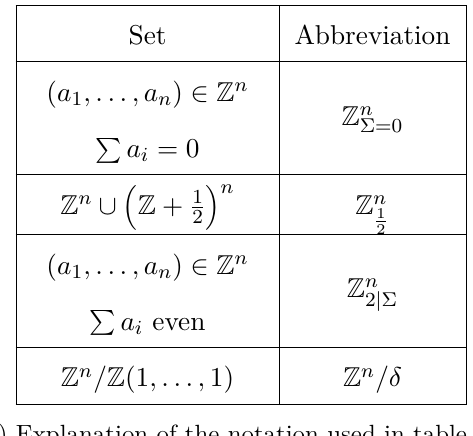
Table 3. The different lattices used in this paper are collected in (a); while the notation is clarified in (b). The lattices Z n and Z n /δ (of rank n − 1 ) are dual, as are the lattices Z n and Z n (of 1 Σ=0 2 | Σ 2 rank n ). Note that, as explained in the text, Λ g and Λ g are not lattices for the non semisimple w cw group U( n ) , whose center is not discrete, so they are not shown in the table. In this case, the root lattice and the weight lattice have ranks differing by